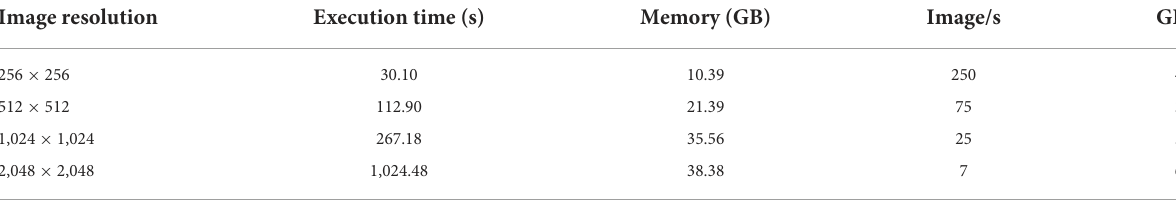
TABLE 5 Assessment of word using mAP by hybrid model.